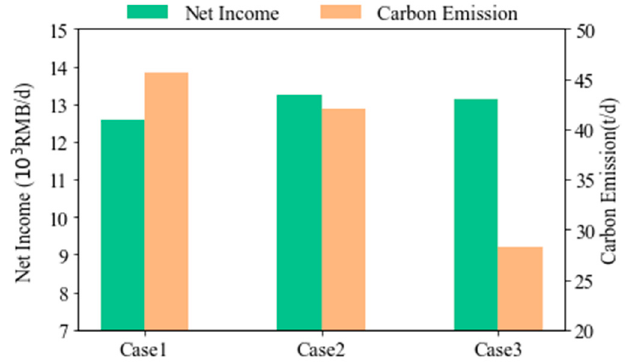
Figure 6. The benefits of operator in summer.